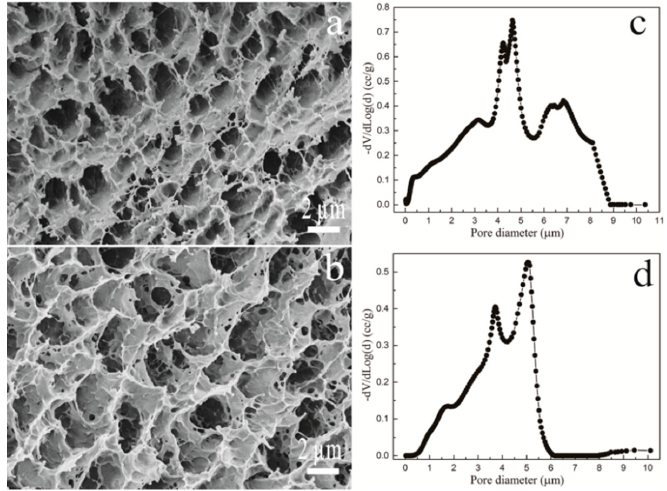
Figure 4. Pore morphology of P407/CMCs hydrogels of PC202 ( a ) (5000×) and PC204 ( b ) (5000×); and the corresponding pore size distribution of PC202 ( c ) and PC204 ( d ).